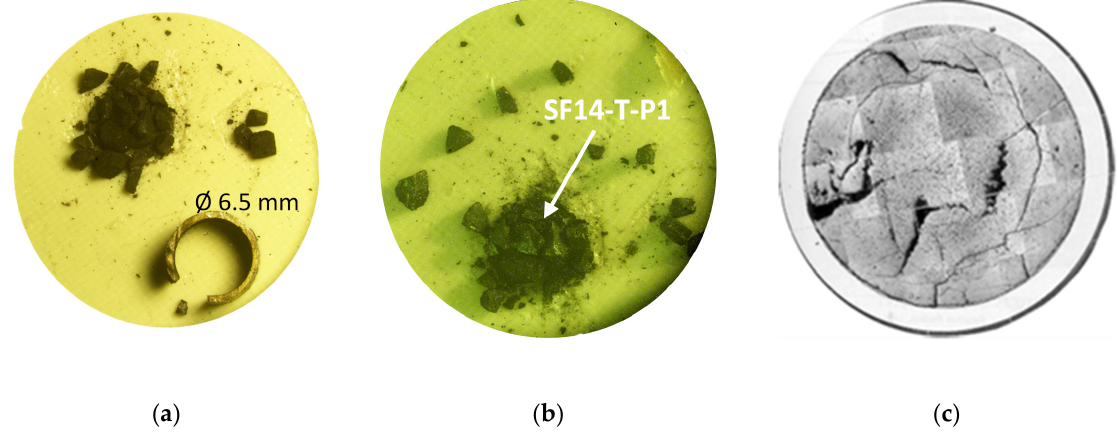
Figure 3. ( a , b ) Optical image of de-cladded fuel and the fragment used (SF14-T-P1) in the reported analyses pointed by an arrow, and ( c ) ceramography of a section of the same rodlet.